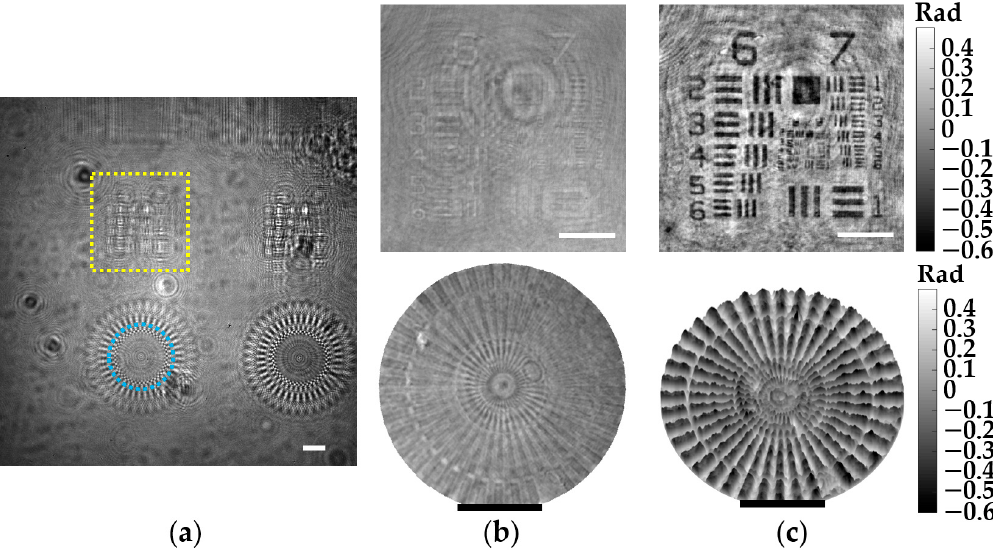
Figure 8. Phase imaging validation of the lensless microscope involving a phase test target. ( a ) Digital in-line hologram for z 1 = 2.2 ± 0.1 mm. ( b ) Retrieved intensity images of the regions marked in ( a ). ( c ) Retrieved 2D (top) and 3D (bottom) phase images of such regions. White and black scale bars represent 100 μ m.